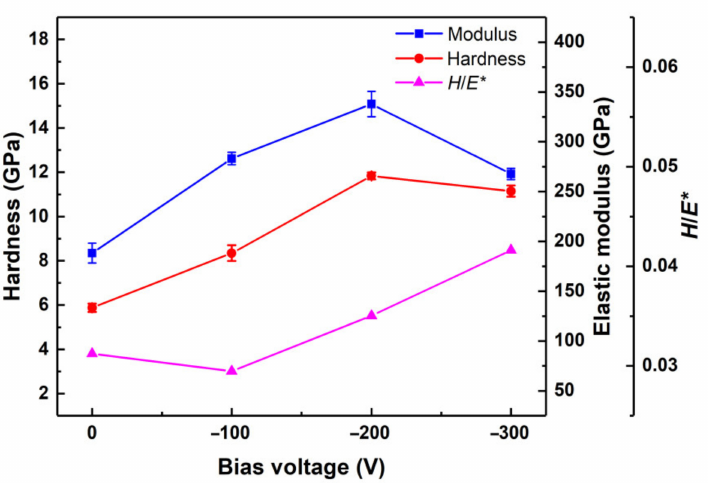
Figure 5. Hardness, elastic modulus and H / E * of the TaN x coatings deposited with different bias